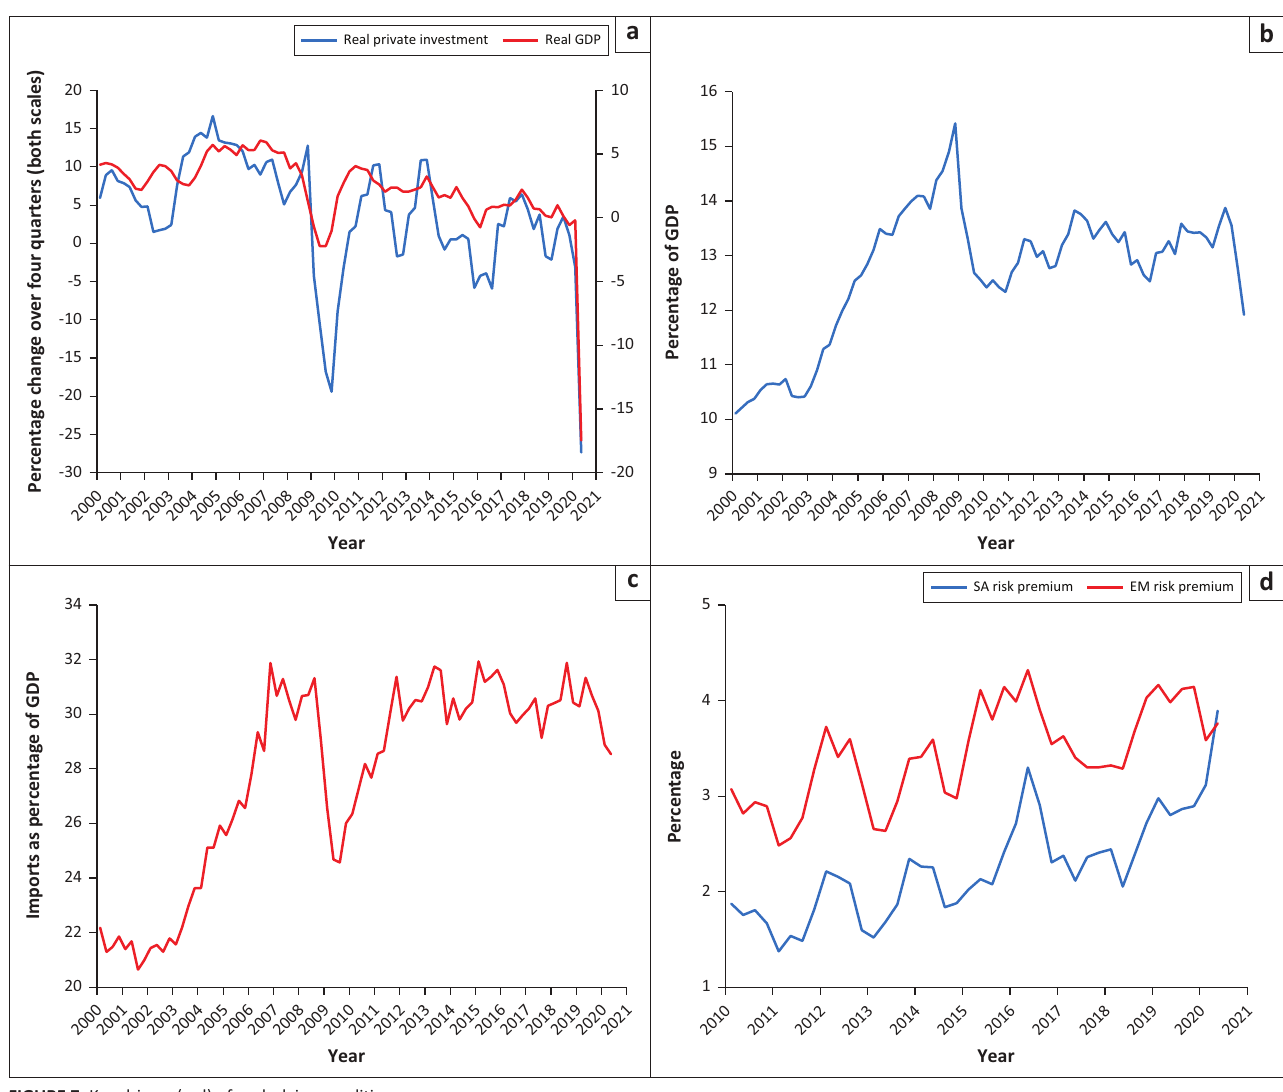
FIGURE 7: Key drivers (a-d) of underlying conditions.